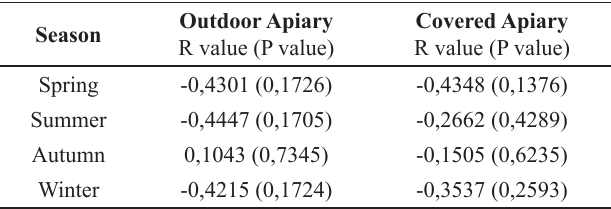
Table 4 . Pearson’s correlation coefficient between pollen production and spore fluctuation in each season